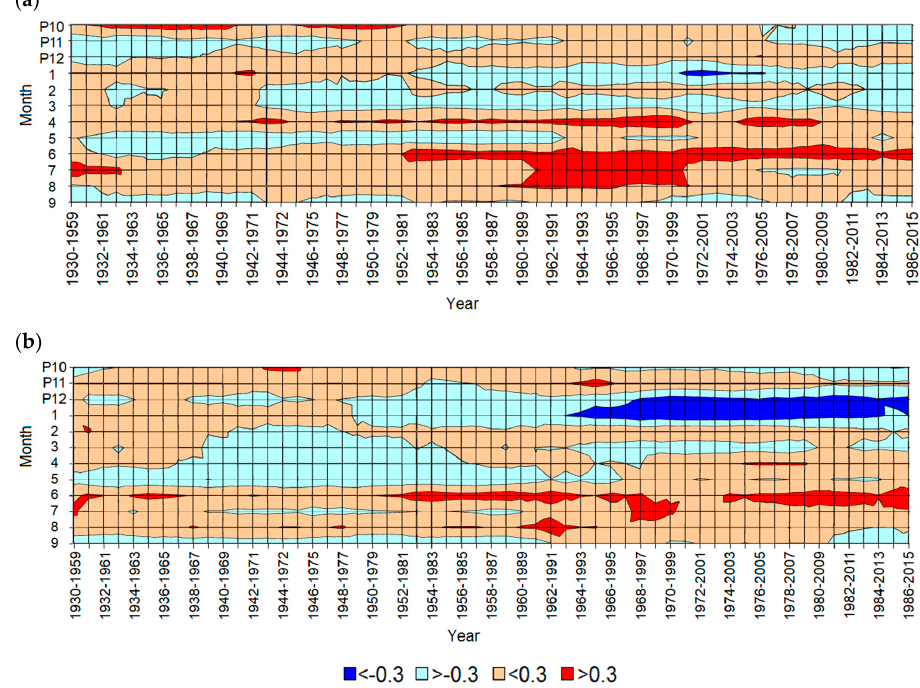
Figure 8. Analysis of the moving correlation for the relation of Scots pine site chronologies—PSO176f (control) ( a ) and PSO142d ( b ) with the precipitation total 1930–2015. Notes: P—previous year. The Pearson’s correlation coefficient at α ≤ 0.1 and for N = 30 is ±0.296, where N is the number of degrees of freedom.